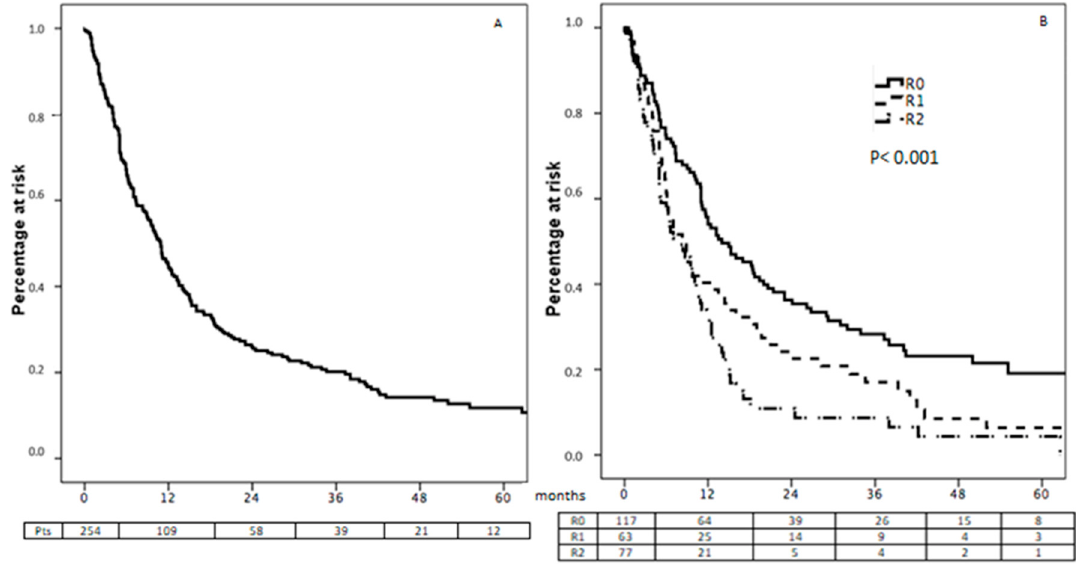
Figure 1. Overall survival in the total population ( A ) and according to the curativity of surgical resection ( B